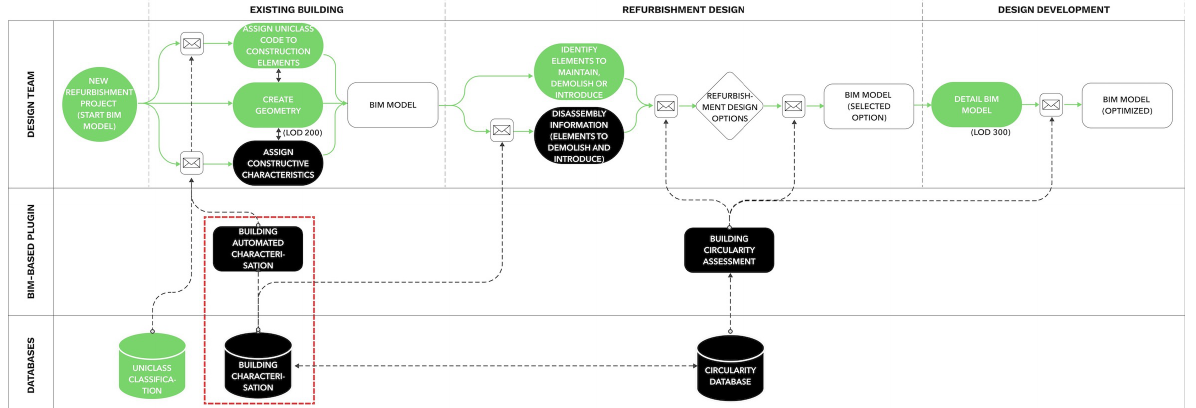
Figure 2. BIM-based circularity assessment conceptual workflow for refurbishment